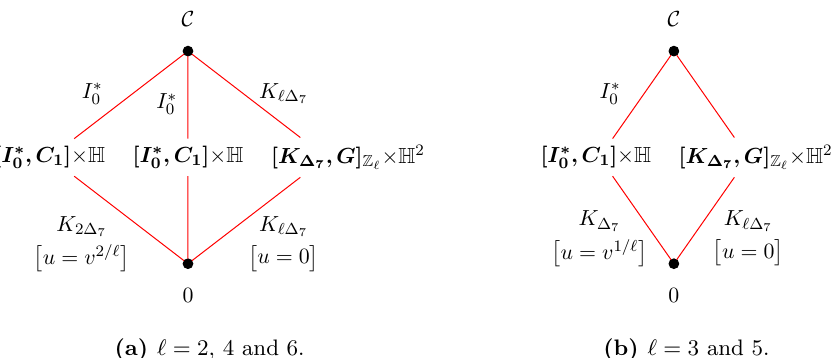
Figure 4. Special K(cid:127)ahler strati(cid:12)cation of T (2)